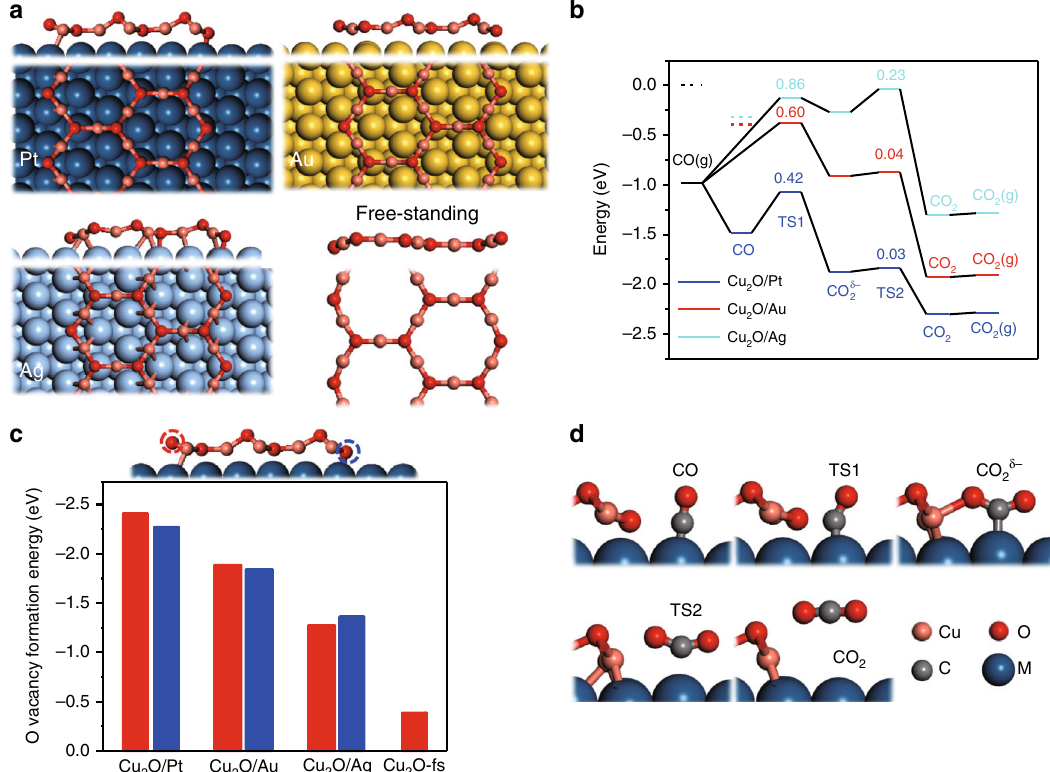
Fig. 6 DFT calculations about CO oxidation reaction on supported Cu 2 O NSs. a DFT-optimized structures of Pt(111), Au(111), Ag(111) supported and freestanding Cu 8 O 6 nanoribbons (denoted as Cu 2 O/M (M = Pt, Au, Ag) and Cu 2 O-fs). b Potential energy diagram for the reaction between CO and O on the stabilized edge of M(111) supported Cu 2 O NSs. The value of barrier is labeled above the corresponding transition state (unit: eV). The energy of CO(g) is represented as the Gibbs free energy of CO under UHV conditions (1 × 10 − 7 mbar) while the black dashed bar at 0 eV marks the DFT-calculated energy of CO without corrections. The red and cyan dashed bars mark the adsorption energy of CO on the top site of Au(111) and Ag(111) surface near the edge of Cu 2 O NSs. c The formation energy of O vacancy for two kinds of O atoms, marked by red and blue dashed circles, at the edges of Cu 2 O/M and Cu 2 O-fs. d The optimized structures for reaction intermediates and transition states (adsorbed CO, transition state 1 (TS1), CO 2 adsorbed with bending con fi guration, transition state 2 (TS2) and CO 2 adsorbed with straight con fi guration) in b .